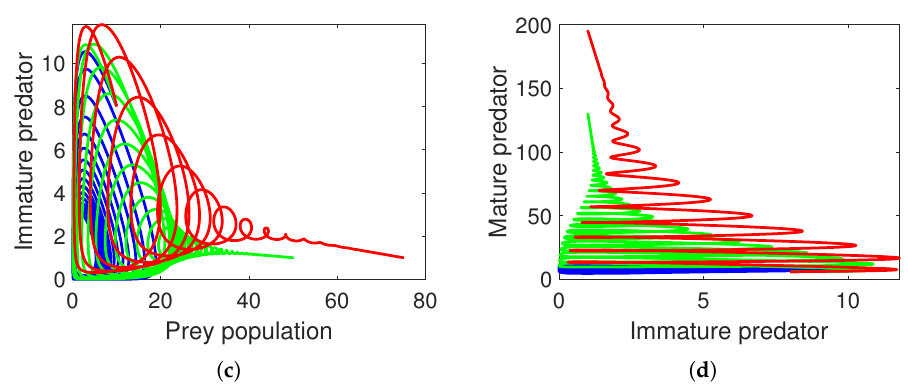
Figure 6. The 2D dynamical behavior of different population with varying parameters L and γ